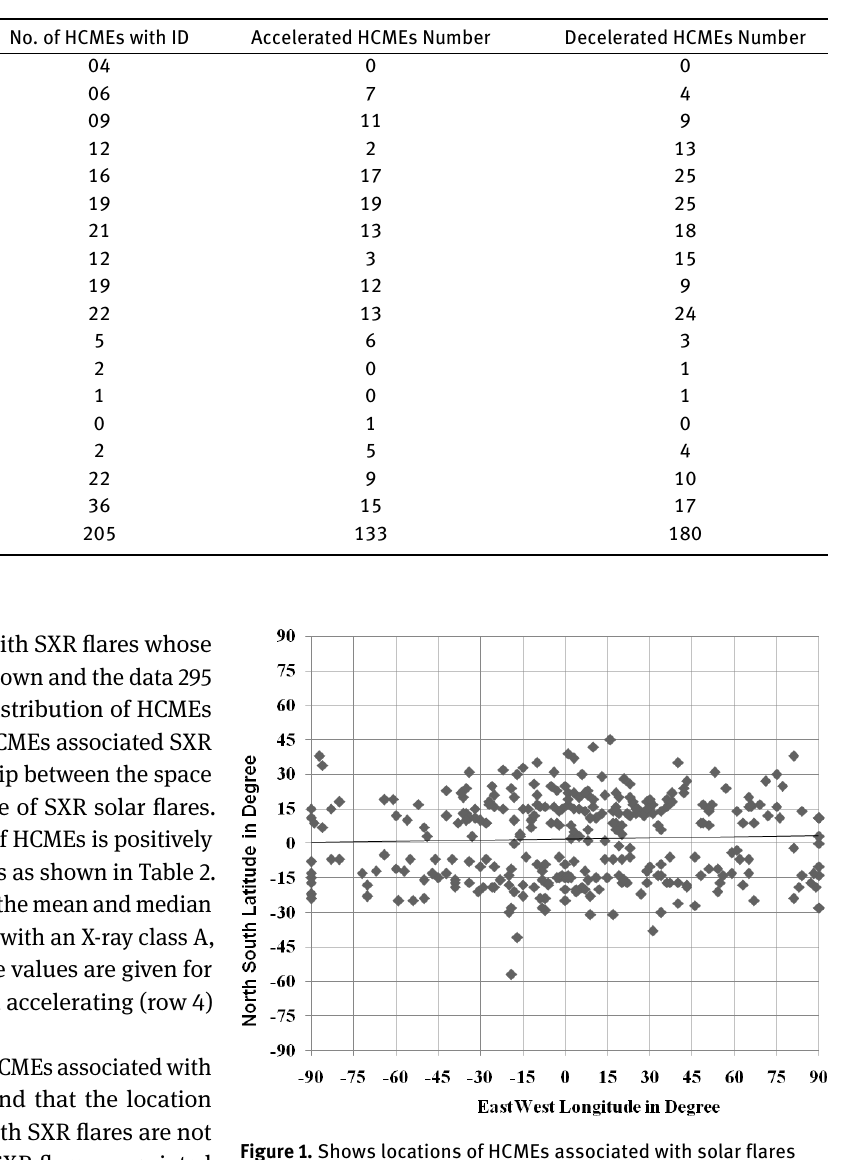
Figure 1 that the source locations of ~95% HCMEs associ- ated solar SXR flares occur within ±30 ∘ solar latitude while solar longitude (east-west longitude) shows that the ~70% HCMEsrelatedsolareventssourcesaremostlyconcentrated within ±40 ∘ solar longitude. Gopalswamy et al.